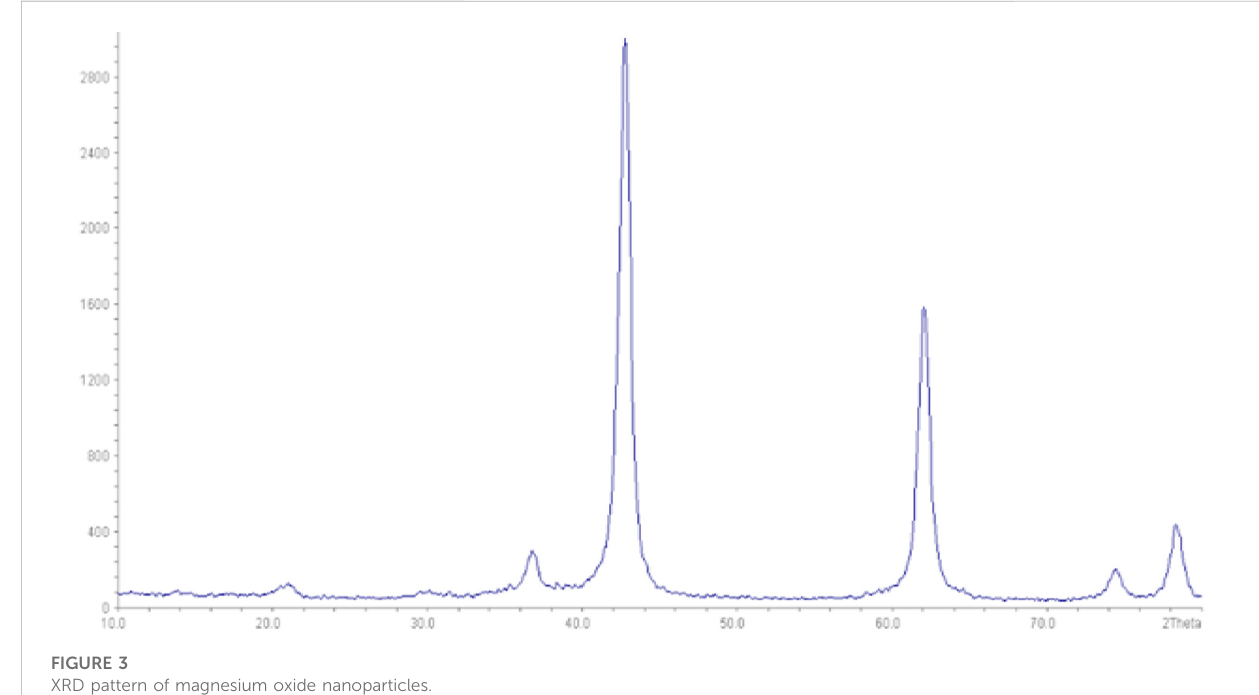
FIGURE 3 XRD pattern of magnesium oxide